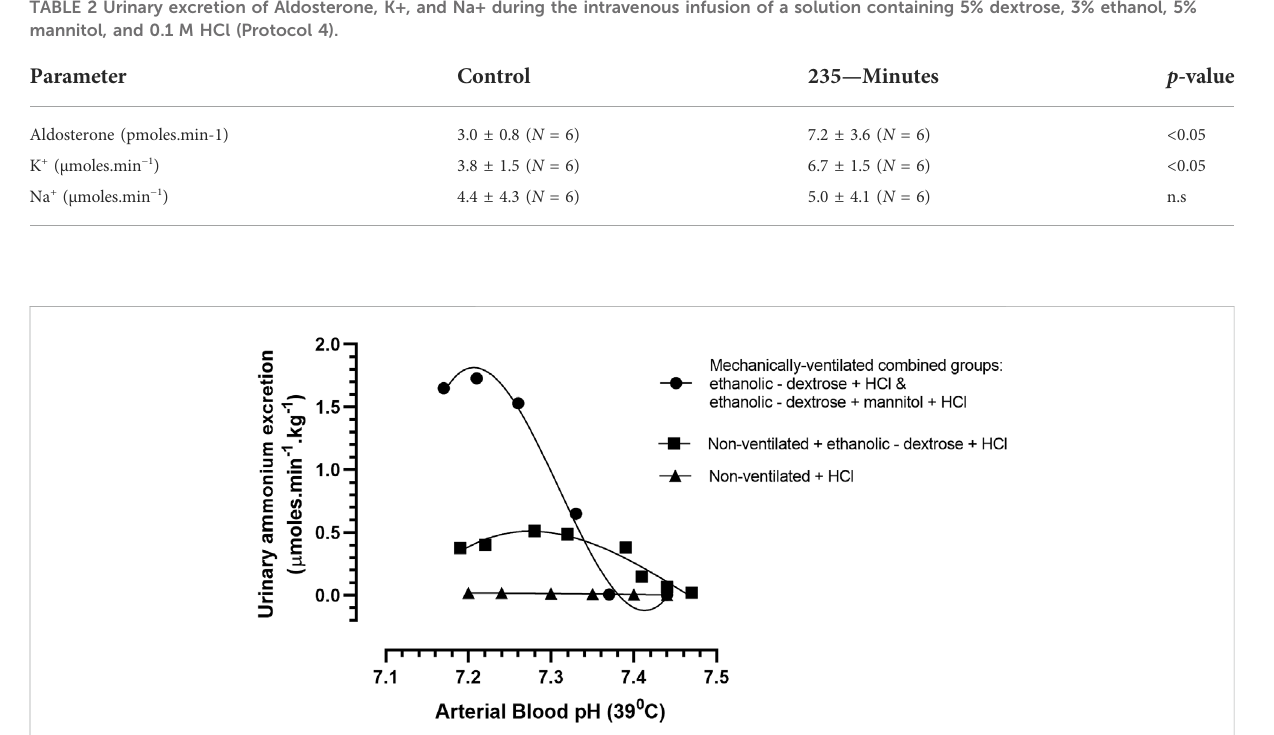
FIGURE 4 Arterial blood pH vs. urinary ammonium excretion rate in rabbits treated according to Protocols 1 – 4: Protocol 1 Control Group (N = 9): 0.9% NaCl+0.1MHCL,non - mechanicallyventilated.Protocol2(N=5):Ethanolic - dextrose+0.1MHCl,non –